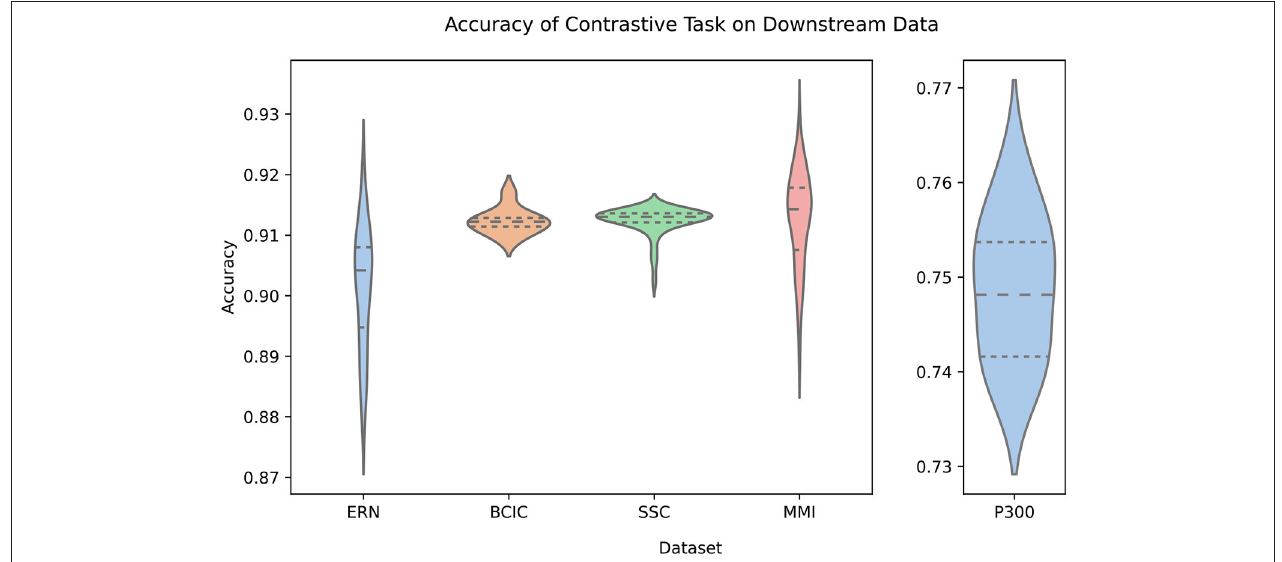
FIGURE 3 | Violin plot (inner lines for quartile divisions) of test subject-wise accuracy for each downstream dataset. Specifically, accuracy of the sequence model (transformer stage) at creating a representation that is closest to the correct representation at masked sequence positions. The P300 dataset is distinctly lower performing (note the adjusted Y -axis) than the remaining datasets, though this was likely due to its shorter evaluation context (see Figure 4 ). Nonetheless, there is minimal test subject-wise variation, particularly when compared to classifier performance generally.